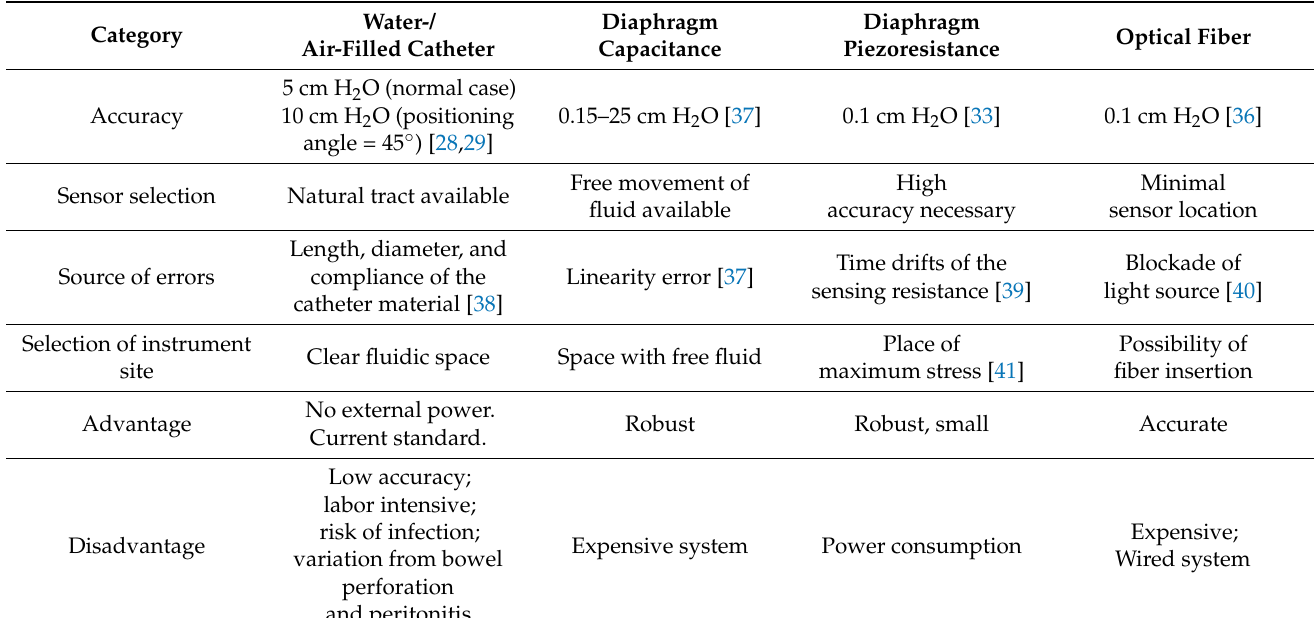
Table 2. Comparison of current intra-abdominal pressure measurement